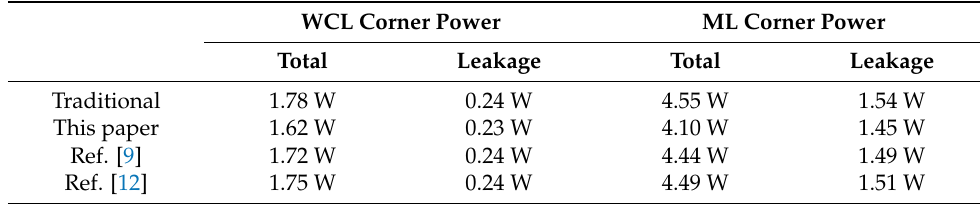
Table 4. Power consumption comparison.